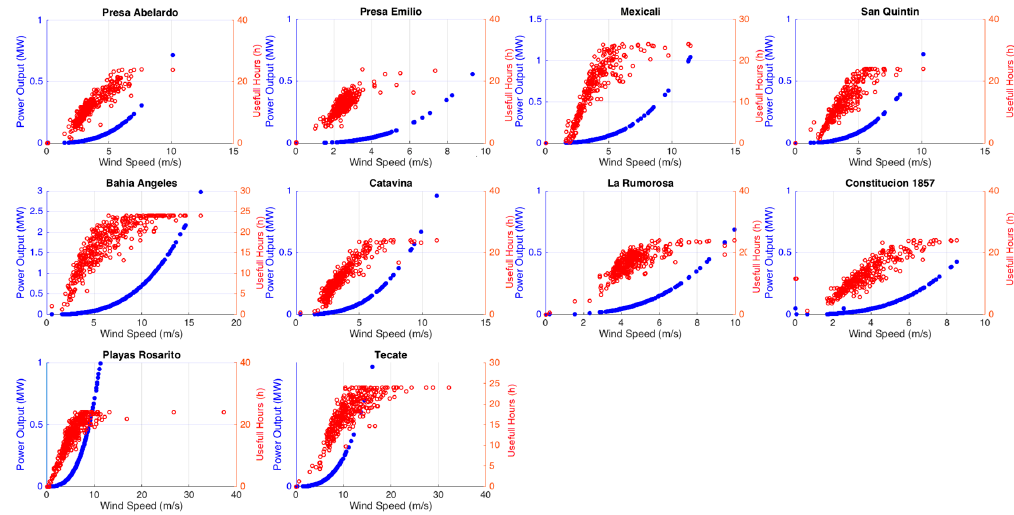
Figure 16. Power output, useful hours and wind speed by AMSs Baja California.